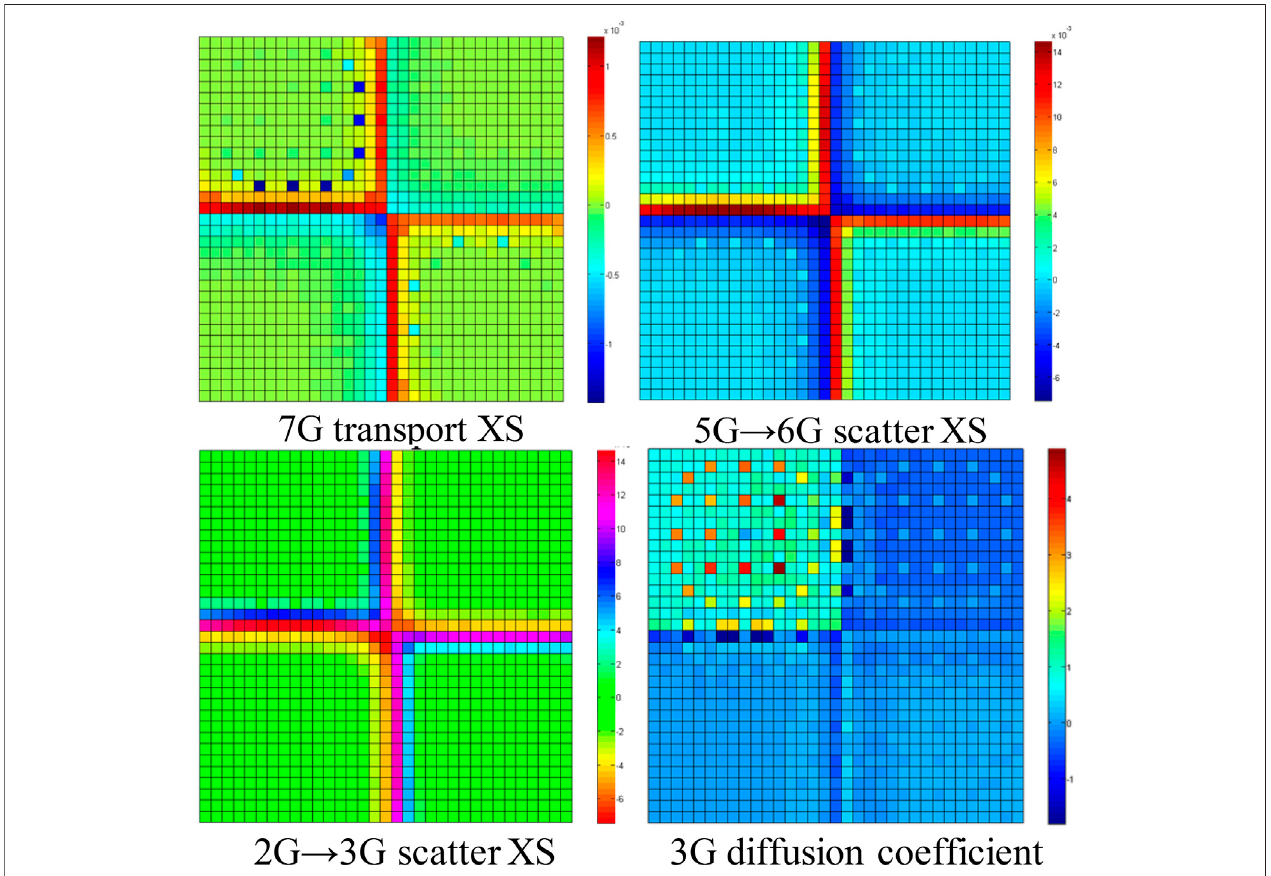
FIGURE 4 | Relative error distributions of the